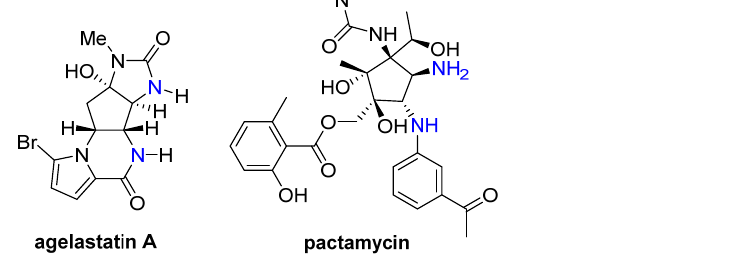
Scheme 1. ( Upper ) Gold(III)-catalyzed organic transformation in the presence of amines. ( Lower ) Gold(III)-catalyzed transformation of furfural into trans